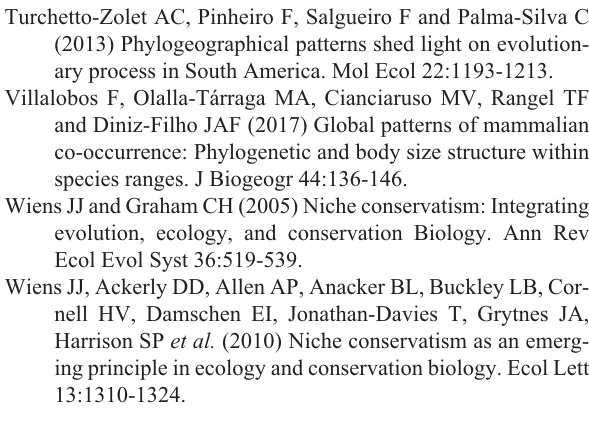
Table S1 - Sampling information for Petunia species. Table S2 - Sampling information for Calibrachoa